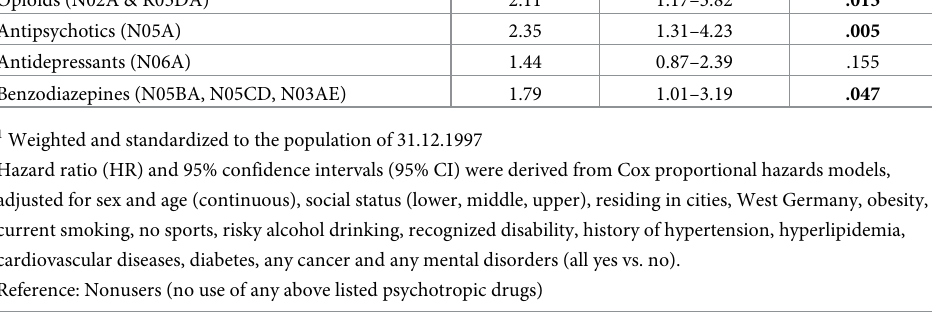
Table 3. All-cause mortality hazard ratio (HR) for the use of psychotropic drugs. GNHIES98 mortality follow-up study. Psychotropic drug users